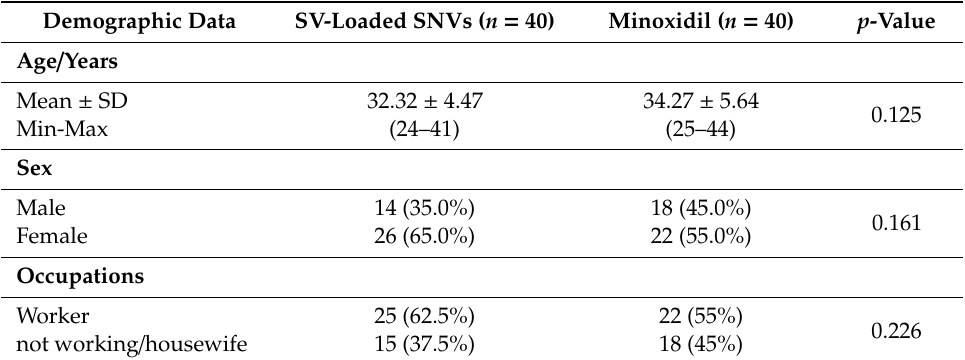
Table 5. Demographic data among the studied groups.